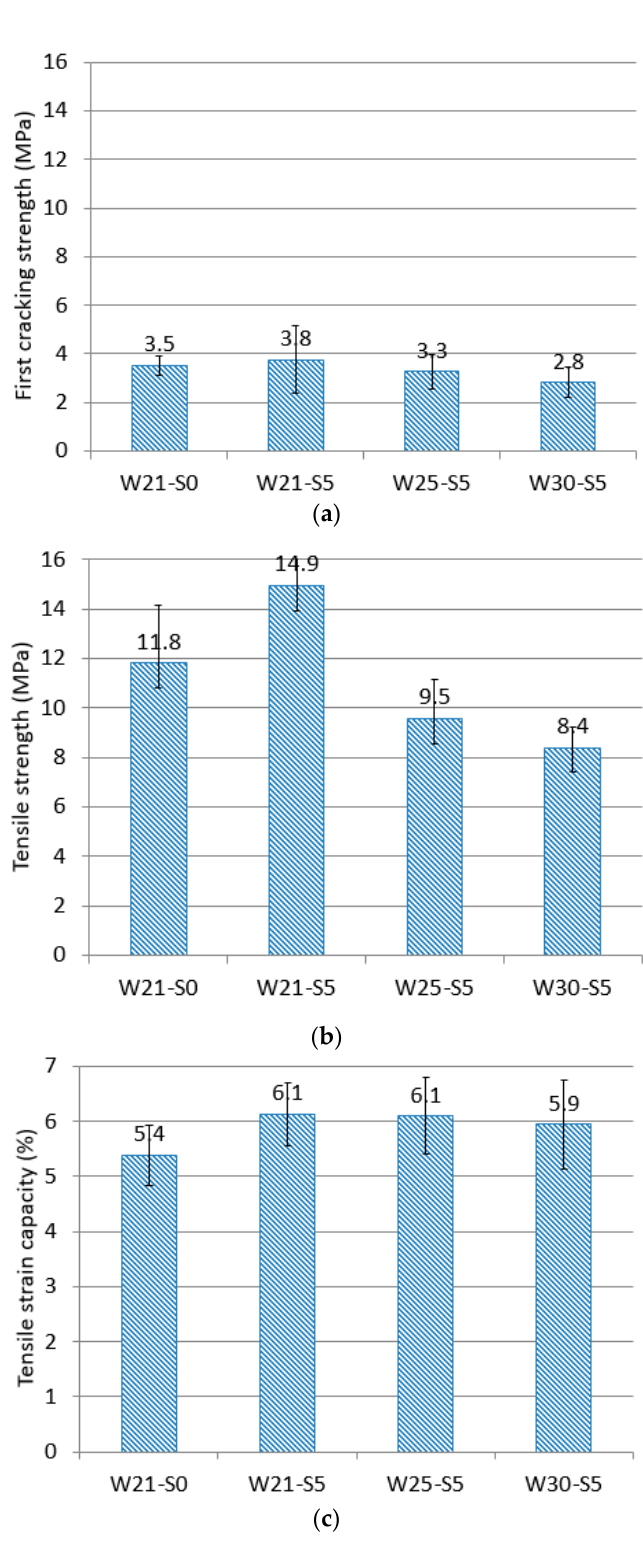
Figure 6. Tensile behavior of each mixture: ( a ) first cracking strength, ( b ) tensile strength, and ( c ) tensile strain capacity.